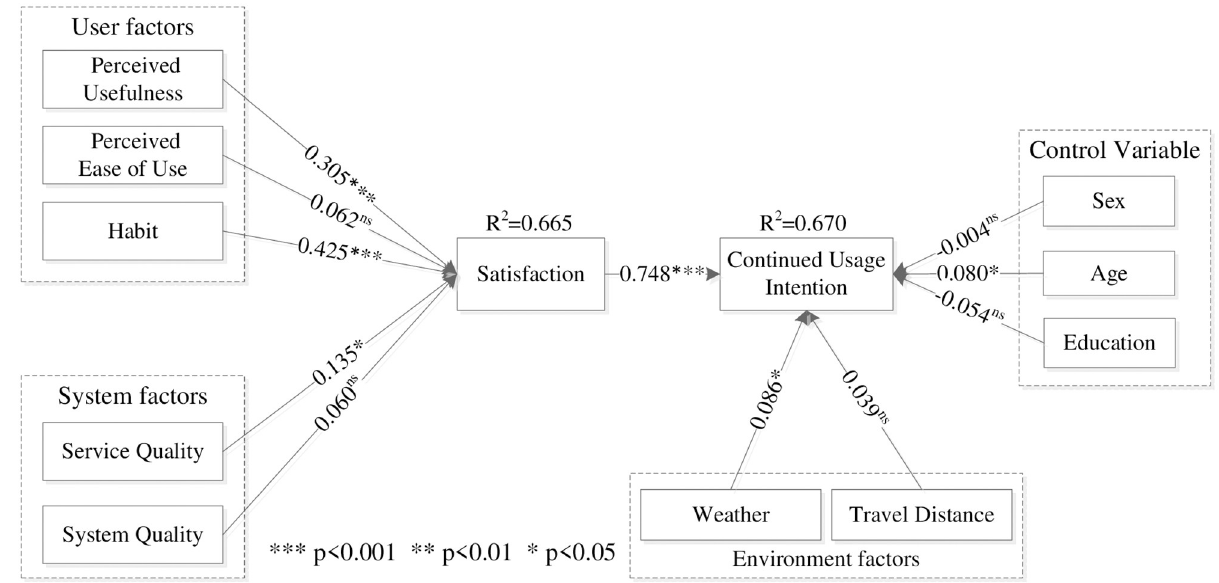
Fig 2. Results of structural model analysis: Pathways to shared bicycle use behavior through user factors, system factors, satisfaction, and environment factors.